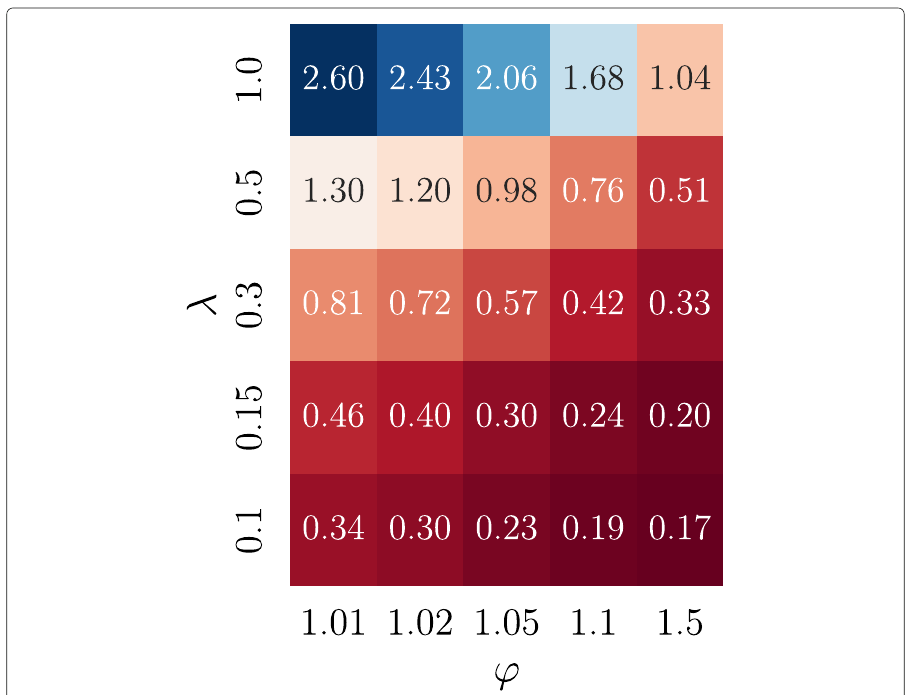
Fig. 8 Difference of objective function value for the optimal pricing horizon and flat pricing